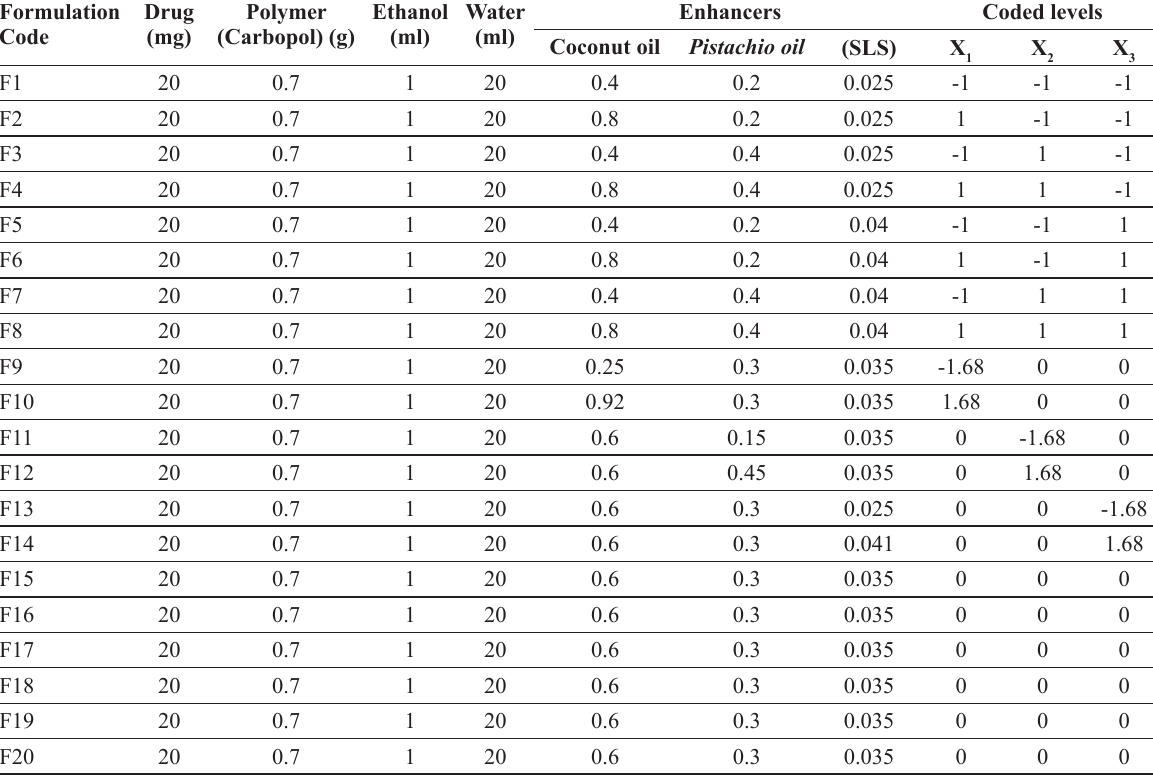
Central Composite Design Experiments and Composition of Clotrimazole gels. Formulation